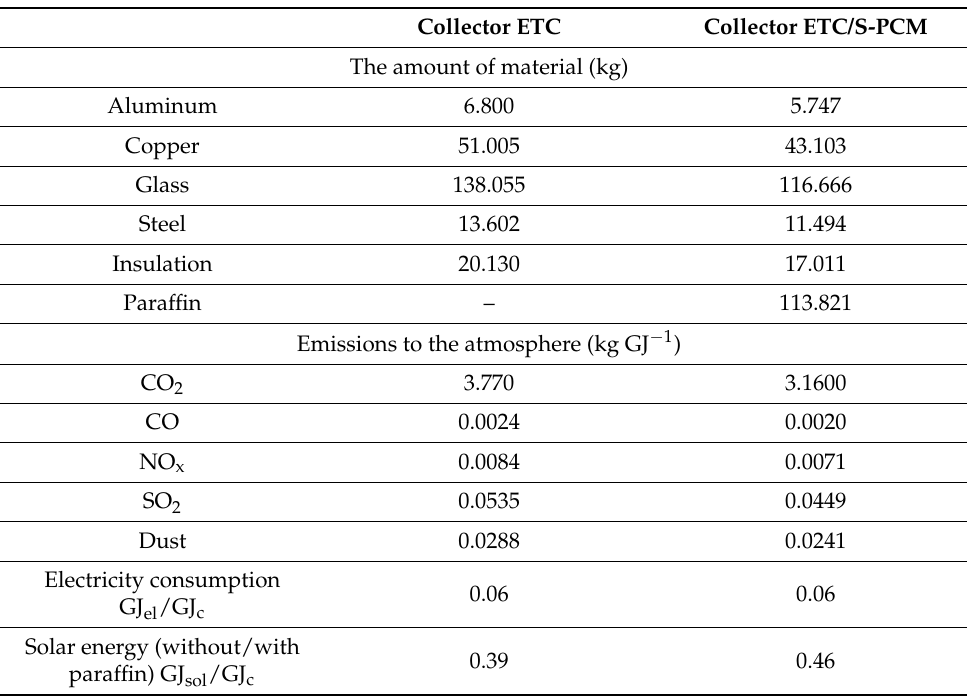
Table 1. The basic types and quantities of materials used in the environmental